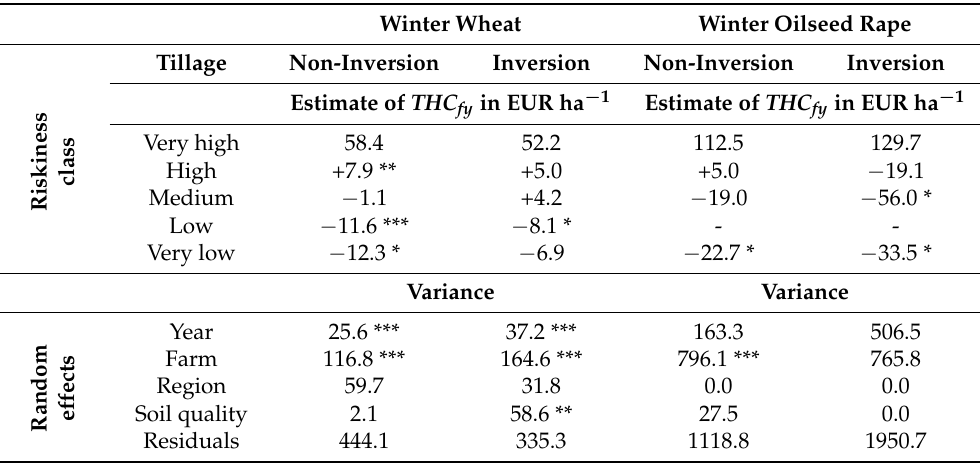
Table 2. Regression: Effect of crop sequence riskiness and tillage on ‘total herbicide costs’ ( THC fy in